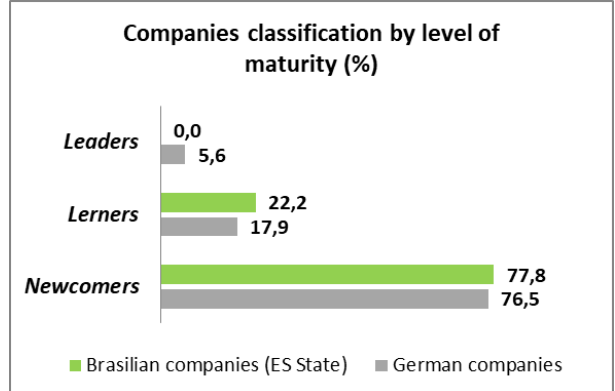
Figure 6. Comparison the classification by groups Newcomers (0 to 1), Learners (2) and Leaders (3 to